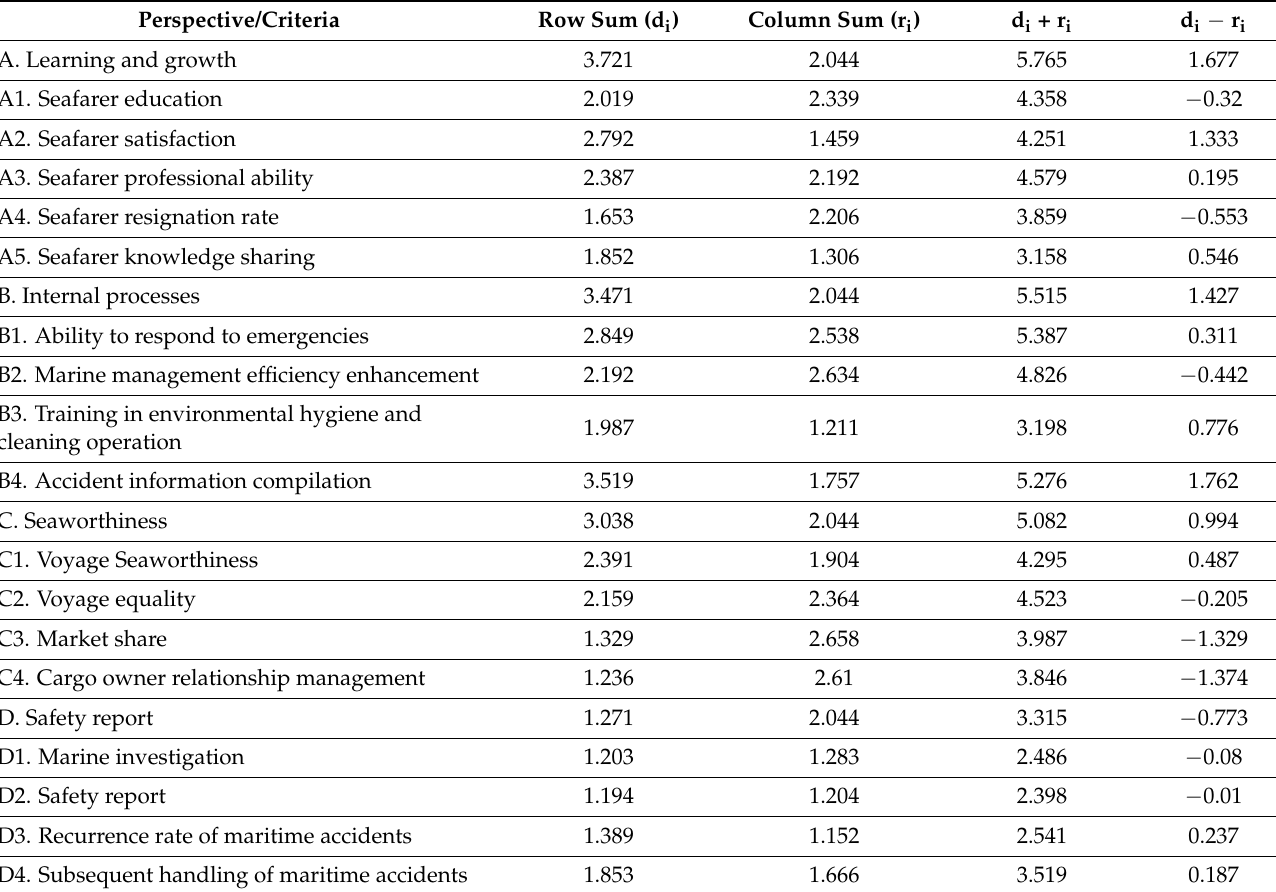
Table 3. Sum of influences given and received on